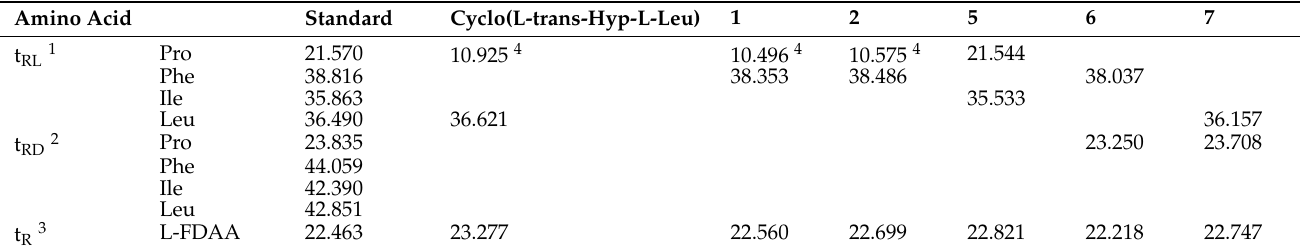
Table 2. The retention times of Marfey’s derivatives of some